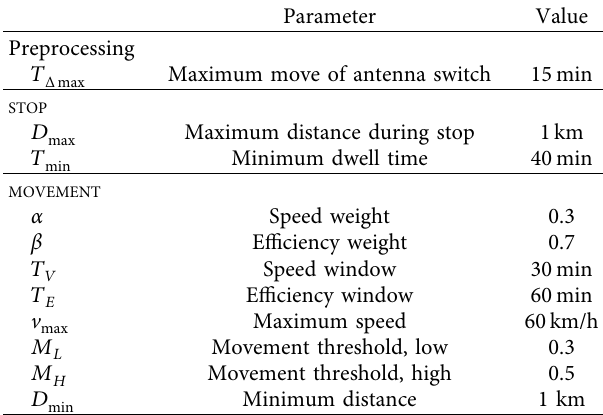
Table 1: Notations used for the trip extraction methods. Notation